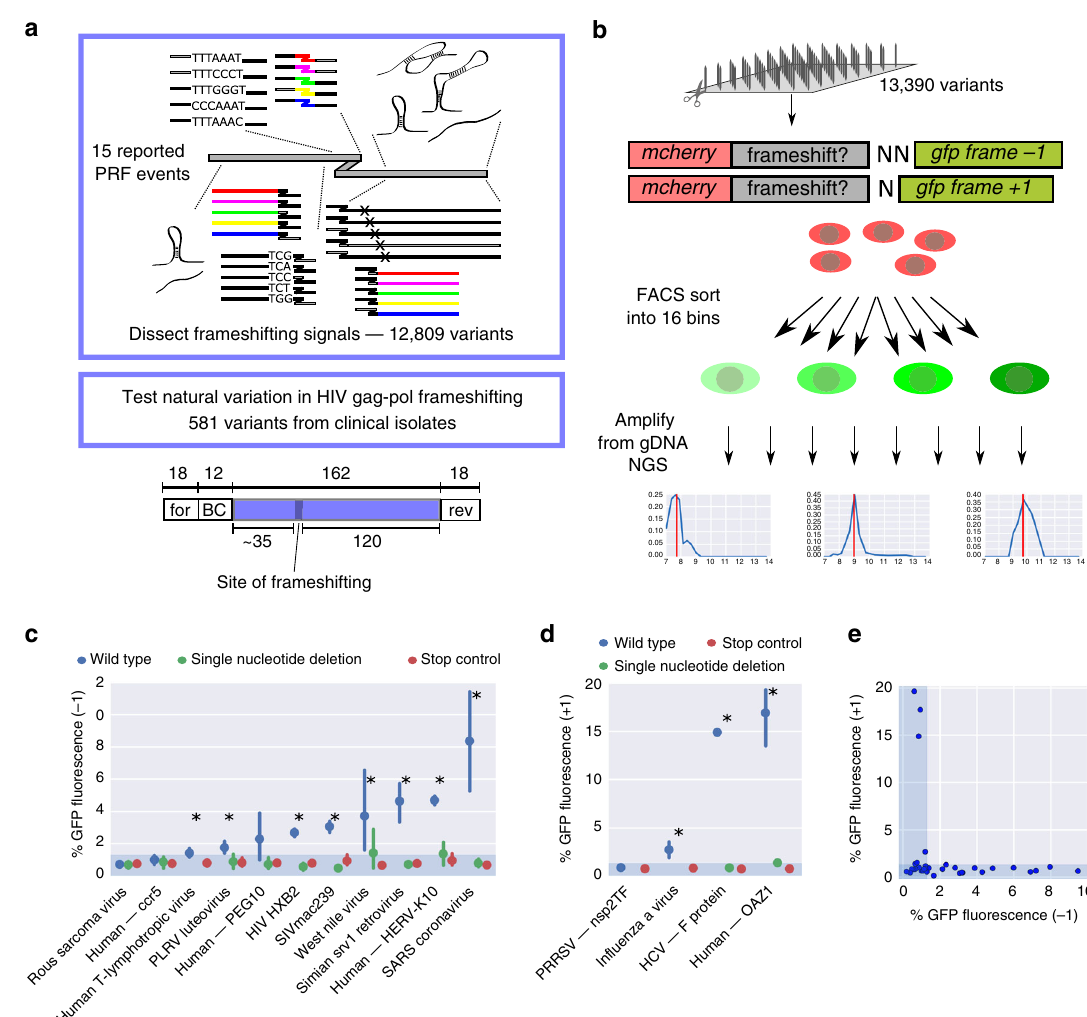
Fig. 1 A massively parallel reporter assay for programmed ribosomal frameshifting. a Schematics of the library design; for forward primer, rev reverse primer, BC barcode. b Outline of the experimental pipeline; the plots in the bottom constitute representative bin pro fi les for variants with no (left), low (middle), or intermediate (right) GFP fl uorescence. c , d Mean ± 95% CI of − 1 ( c ) and + 1 ( d ) PRF signal (% GFP fl uorescence) for barcode control groups corresponding to the indicated wild-type PRF sequences (blue), carrying single nucleotide deletions (green) or having a stop codon inserted upstream of the frameshift sequence (red); n = 22, 2, 13, 32, 10, 25, 21, 8, 13, 24, 9 ( c ) and 2, 2, 1, 10 ( d ) wild-type sequences (blue), and n = 32, 7, 12, 33, 28, 23, 23, 21, 14, 23, 40 ( c ) and 11, 7, 19, 20 ( d ) sequences with deletion or stop codon (green and red) tested, in the order they appear on the graph; the shaded area denotes the range of background fl uorescence; asterisks denote signi fi cant differences between the wild type and the other groups (single nucleotide deletion and stop control) combined (Mann – Whitney U test). e Comparison of − 1 and + 1 PRF reporter readout (% GFP fl uorescence) for previously reported PRF sites (cf. c , d , Supplementary Fig. 3a,